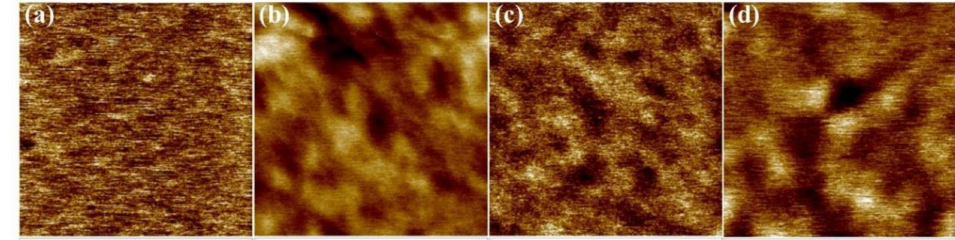
Figure 4. AFM-Phase images of the ( a ) 6FDA-CE-PI, ( b ) CE-PDMS-2.5, ( c ) CE-PDMS-5, and ( d ) CE- PDMS-10 membranes (scale: 500